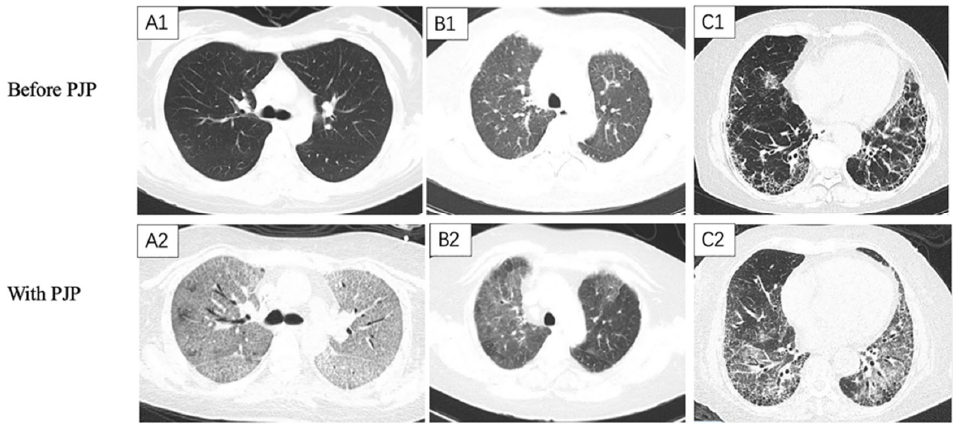
Figure 1. Chest CT scanning of Pneumocystis jirovecii pneumonia (PJP) with different underlying pulmonary diseases: (1) ( A1 , A2 ) A 52 year old female nephrotic syndrome patient without underlying pulmonary disease suffered from PJP 3 months later. ( A1 ) Chest CT scan (16 April 2019) shows normal lung parenchymal before the administration of prednisone and mycophenolate mofetil. ( A2 ) Chest CT scan (11 July 2019) obtained 3 months later showing diffuse ground ‐ glass opacities (GGOs) and multiple traction bronchiectasis. She suffered from fever and dyspnea on July 2, 2019. She was diagnosed with PJP on 12 July 2019. (2) ( B1 , B2 ) A 36 year old female eosinophilic granulomatosis with polyangiitis patients with non ‐ fibrosing interstitial lung disease was complicated with PJP 2 months later. ( B1 ) Chest CT scan (8 March 2017) show diffused GGOs throughout the bilateral lungs before the administration of prednisone and iv. cyclophosphamide. ( B2 ) Chest CT scan (5 May 2017) obtained 2 months later shows relapsing diffused GGOs in the right upper lobe and local GGOs in the left upper lobe. She complained of fever and dyspnea on 1 May 2017. She was diagnosed with PJP on 9 May 2017. (3) ( C1 , C2 ) A 60 year old male rheumatoid arthritis patients with fibrotic interstitial lung disease (FILD) was complicated with PJP 3 months later. ( C1 ) Chest CT scan (11 May 2019) shows bilateral subpleural with basal predominance of the reticulation, interlobular septal thickening, and scattered honeycombs before the administration of Tofacitinib. ( C2 ) Chest CT scan (8 August 2019) obtained 3 months later shows diffused GGOs and multiple traction bronchiectasis in the background of FILD. He had suffered from exaggerated dyspnea since August 3, 2019. He was diagnosed with PJP on 11 August 2019.